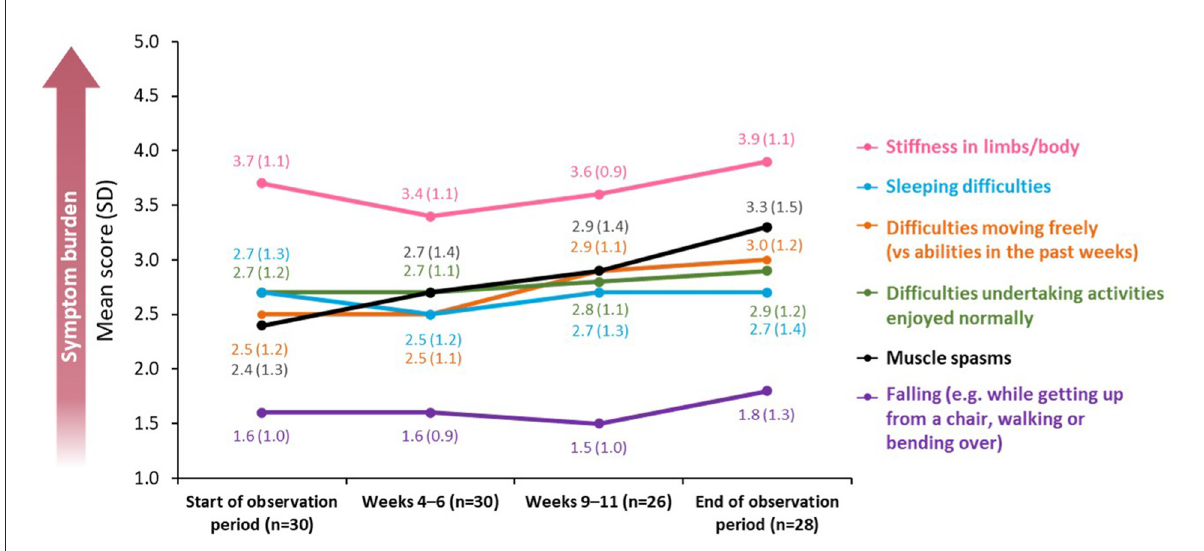
FIGURE2 Changes in symptom burden and disability across a BoNT-A treatment cycle. BoNT-A, botulinum neurotoxin A; SD, standard deviation.